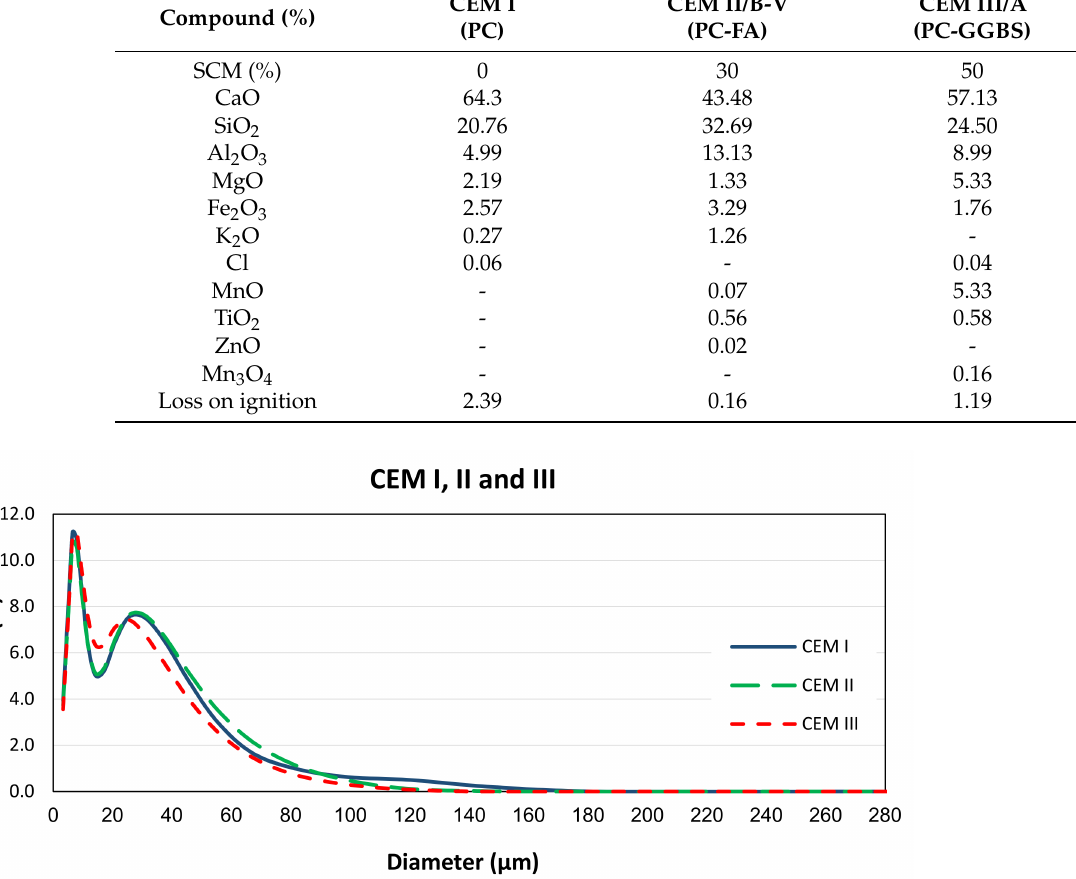
Figure 4. Particle size distributions of CEM I (PC), CEM II (PC-FA), and CEM III (PC-GGBS).